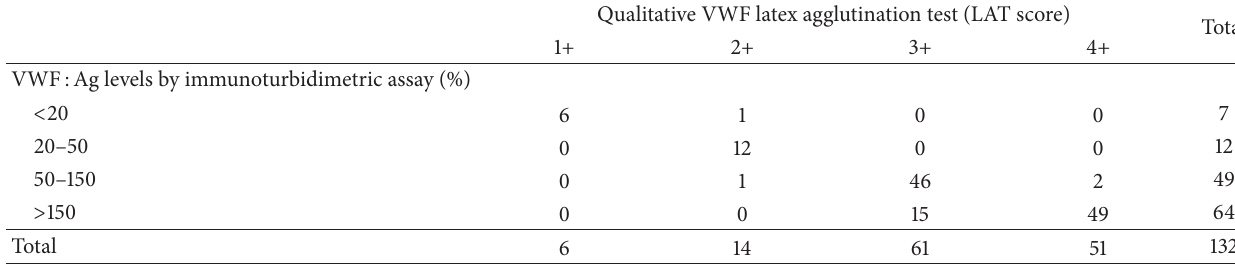
Table 6: Crosstabulation of VWF antigen levels and qualitative VWF by latex agglutination test